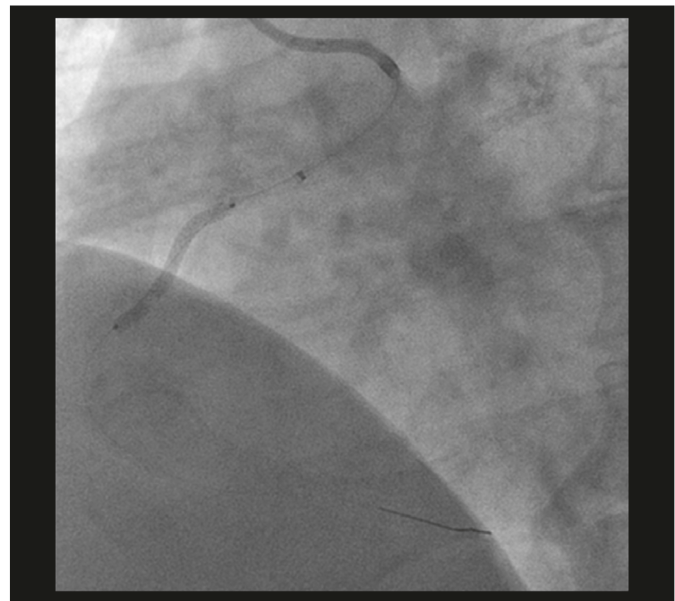
Figure 3: Successful stent deployment within the lesion.